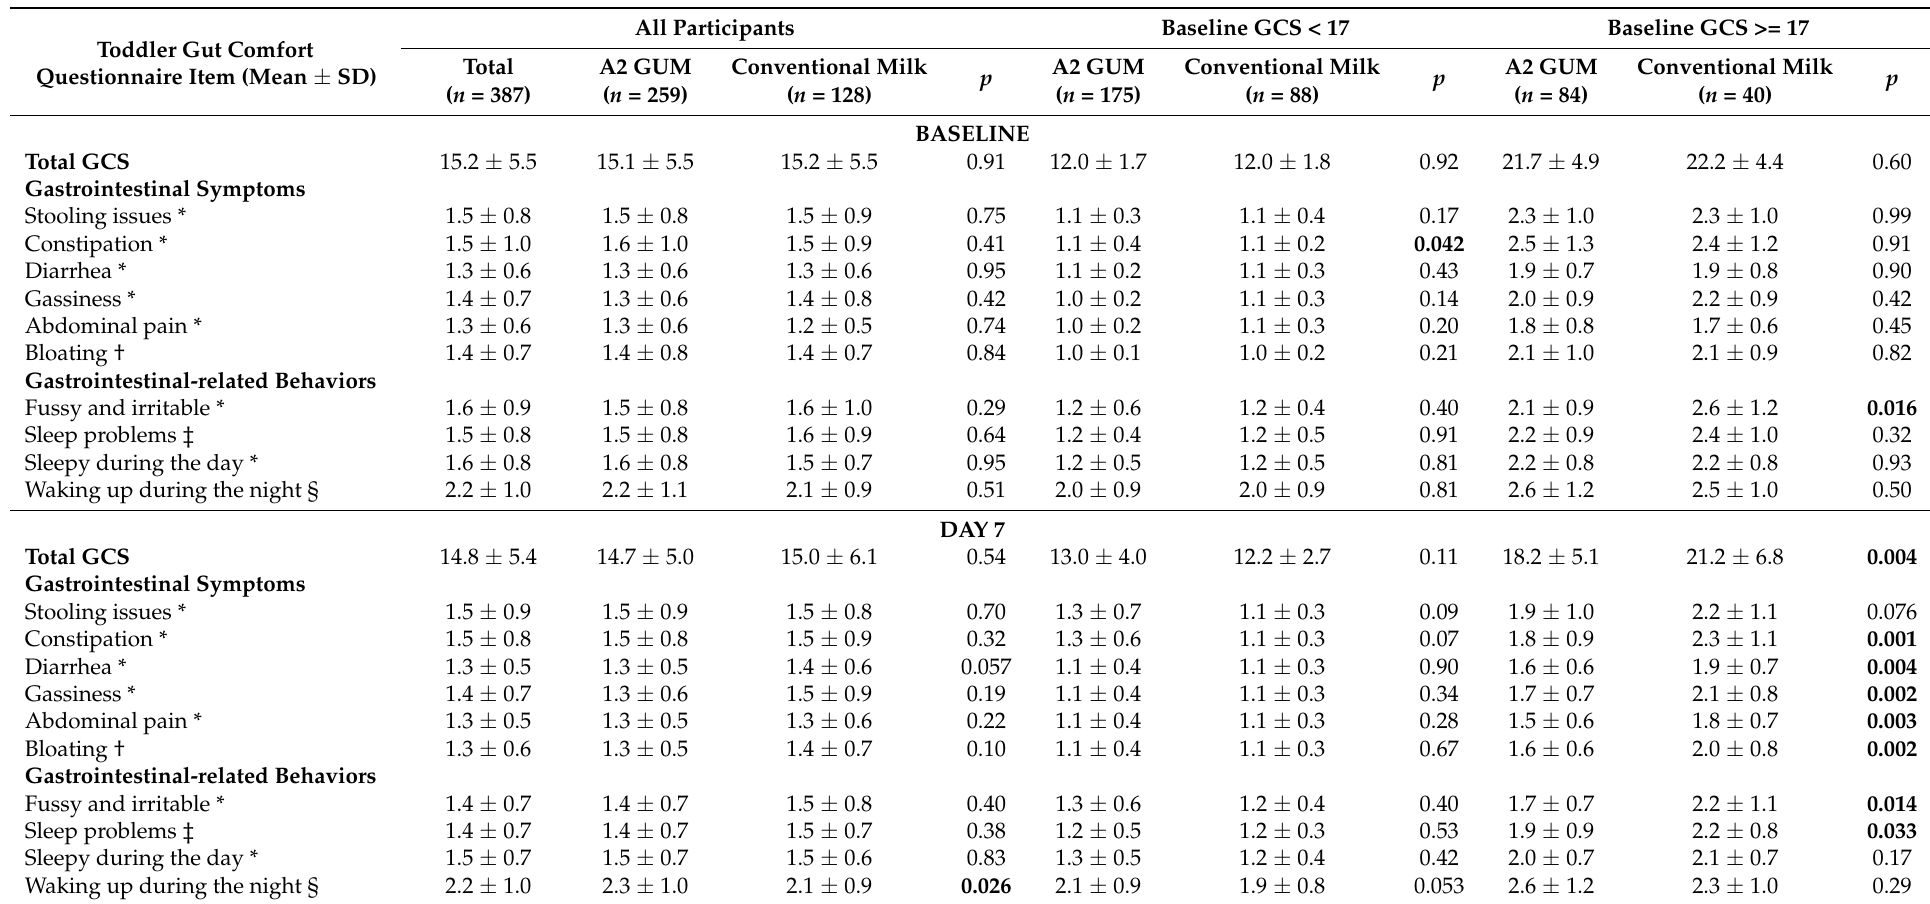
Table 2. GI symptom scores from the Toddler Gut Comfort Questionnaire at baseline, day 7, and day 14 among all participants and stratified by baseline Gut Comfort Score